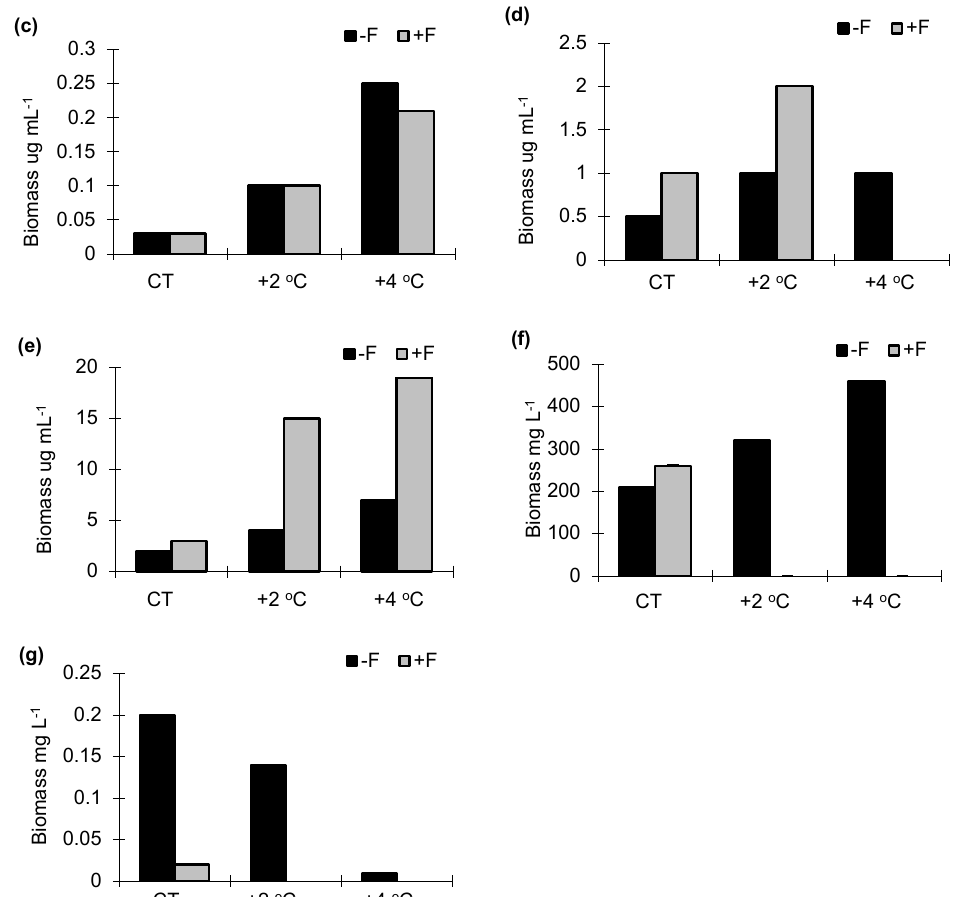
Figure 3. Biomass of ( a ) phycoflora; ( b ) bacteria; ( c ) heterotrophic flagellates; ( d ) testate amoebae; ( e ) ciliates; ( f ) cladocerans; ( g ) copepods in experimental mesocosms. − F treatments without fish; +F treatments with fish; CT—control treatments; +2 °C—treatment with temperature increased by +2 °C relative to the control; +4 °C—treatment with temperature increased by +4 °C relative to the control.